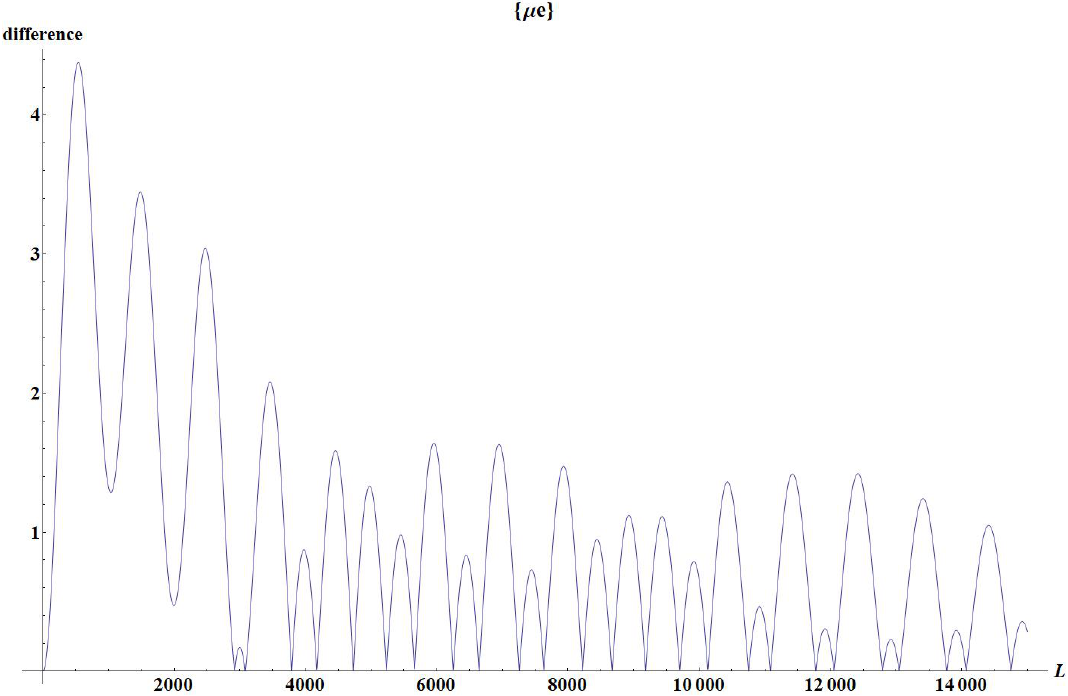
Figure 12. Percentage difference of the two probabilities from the previous plot (LI and LIV). Baseline L in